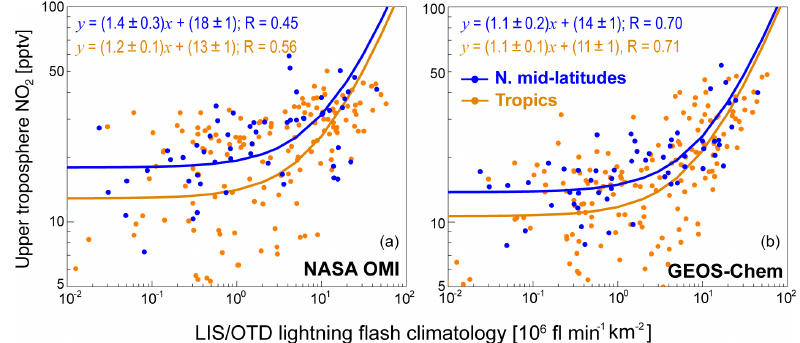
Figure 6. Log–log relationship between upper troposphere NO 2 and lightning flash frequencies, and linear regression fits between the two. Individual points are coincident seasonal mean UT NO 2 from OMI (a) and GEOS-Chem (b) versus seasonal mean LIS/OTD lightning flash climatologies for coincident 20 ◦ × 32 ◦ grid squares in the northern midlatitudes ( > 30 ◦ N; blue) and tropics ( < 30 ◦ N; orange). Northern midlatitude points exclude December–February, which show poor correlation with lightning flashes (see text for details). Lines and legends show reduced major axis linear regression fits to the data with corresponding Pearson’s correlation coefficients. The regression lines plot as curves on the log–log scale, highlighting the NO 2 background at low lightning flash rates and the correlation of NO 2 with lightning at high flash rates.